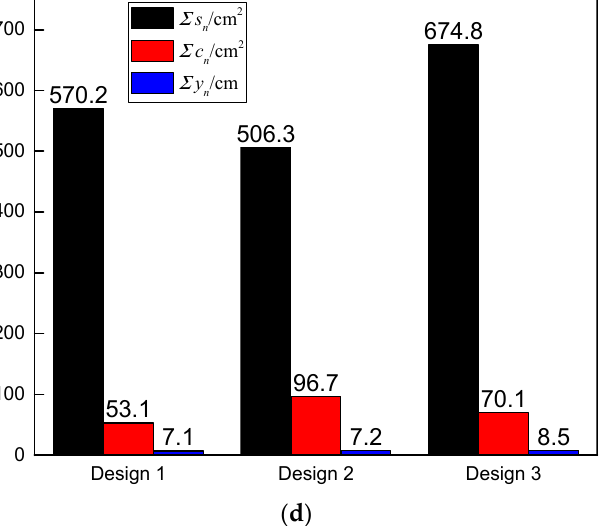
Figure 10. Damage to impacted plates.: ( a ) perforation; ( b ) deformation; ( c ) deflection; ( d ) accumulated damage: S for the steel plate and A for the aluminum plate.